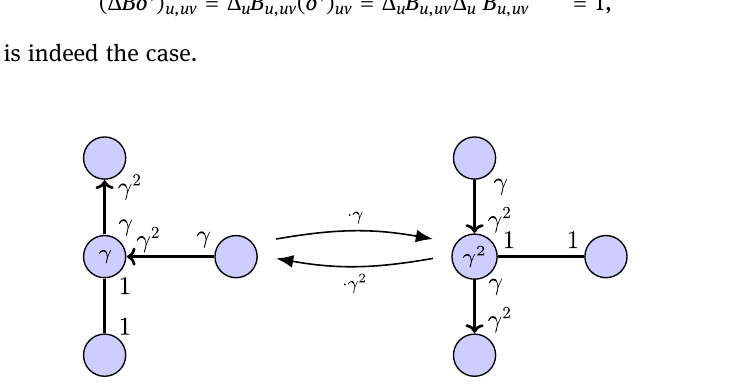
Figure 4: Pattern for switching an α - monograph into its undirected